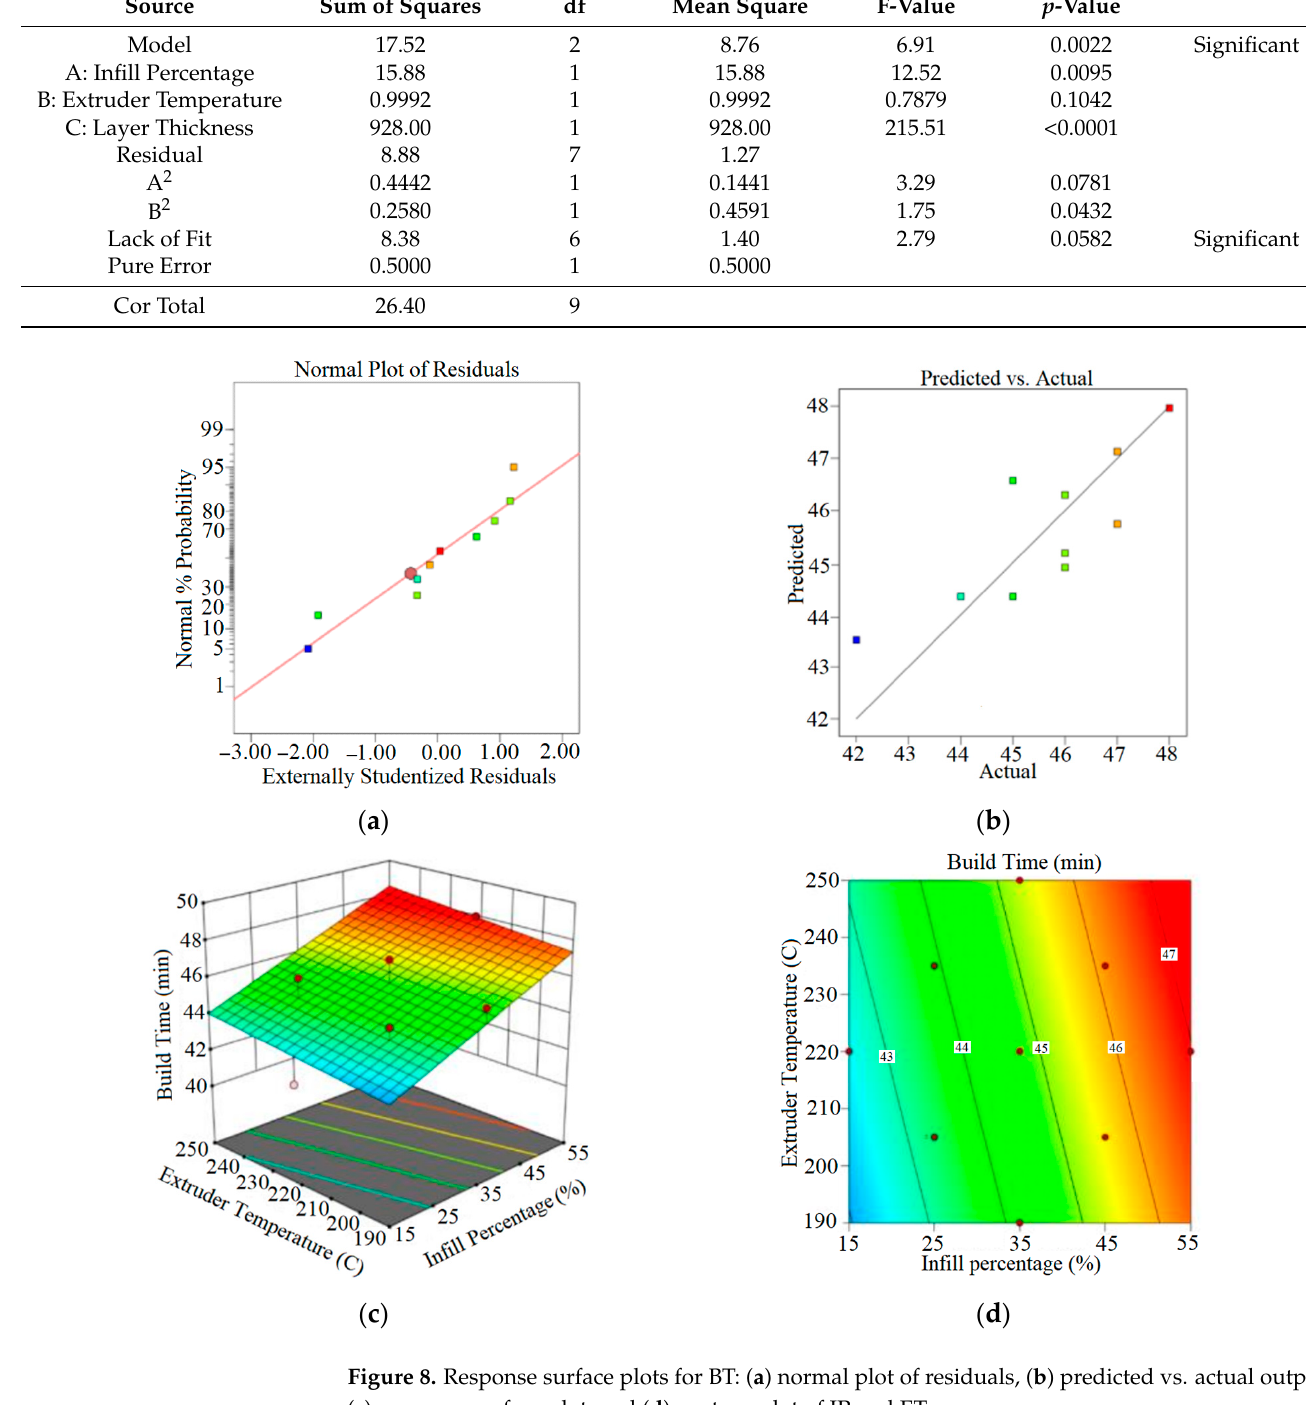
Figure 8. Response surface plots for BT: ( a ) normal plot of residuals, ( b ) predicted vs. actual output, ( c ) response surface plot, and ( d ) contour plot of IP and ET.